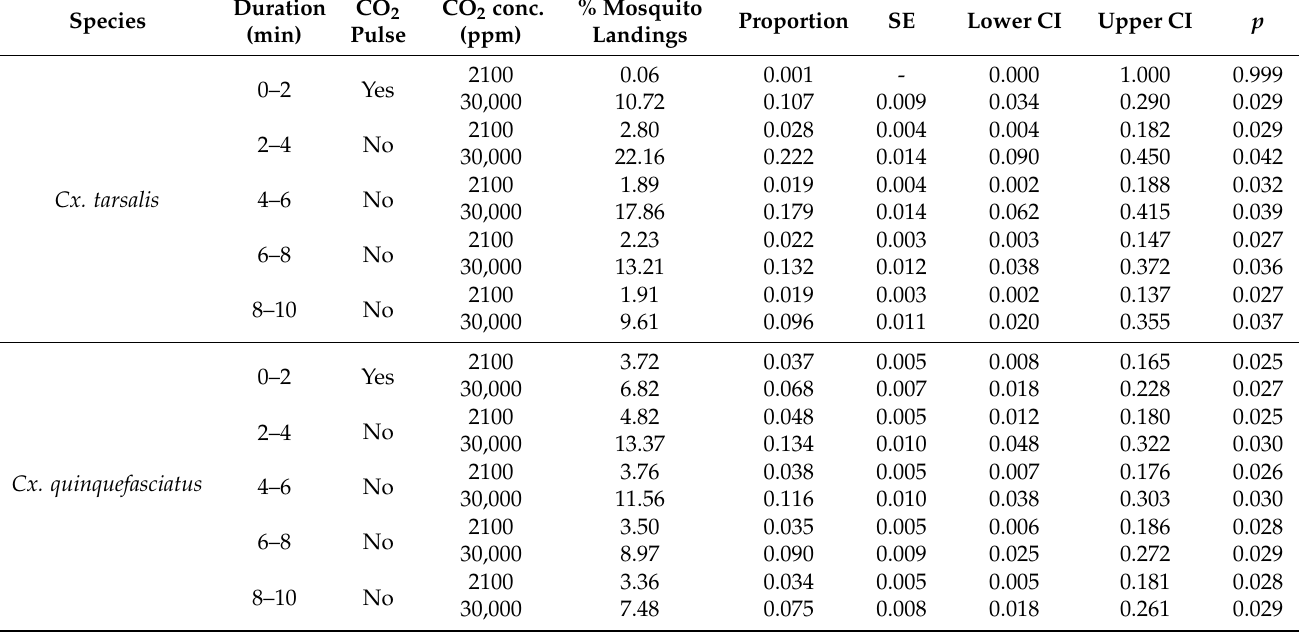
Table 2. Proportion of mosquito landings on Peltier warm as a function of the duration of exposure to the thermal stimuli in the heat-seeking